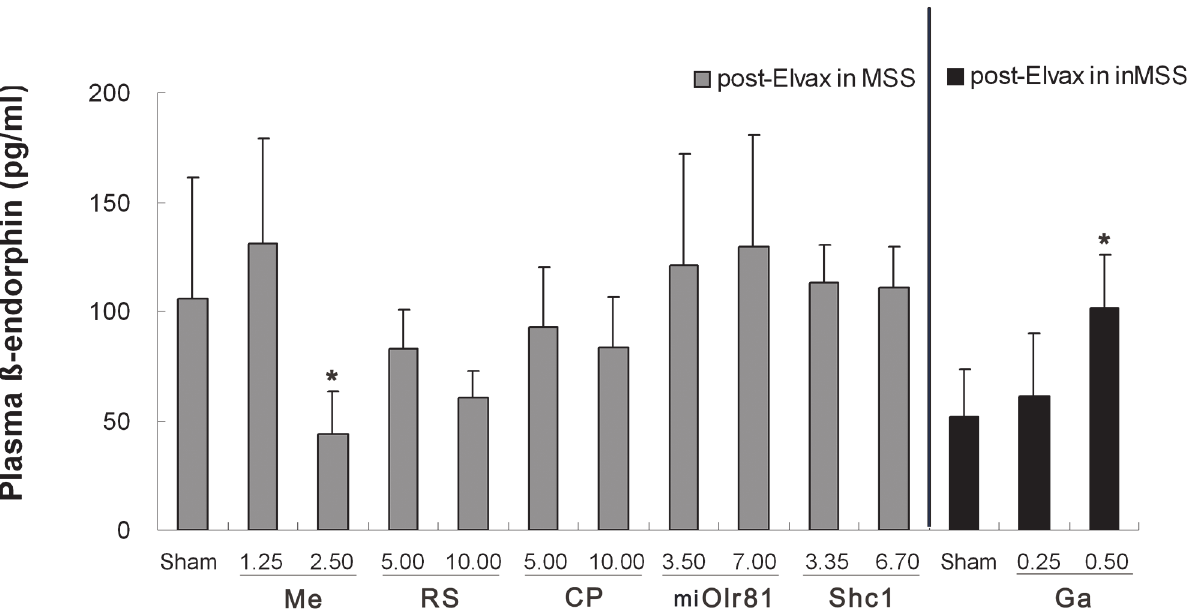
Fig 7. Effects of Elvax implantation over the CVN on plasma β -endorphin level after rotation stimulation. The final concentration of mecamylamine (Me), RS39604 (RS, CP99994 (CP) and gabazine (Ga) and the final titer of pAd-shOlr81 (shOlr81) and pAd-Shc1 (Shc1) in Elvax, and the number of animals used in each treatment group are the same as those in Fig 5. All data presented were expressed as the mean and vertical bars represent SEM. * P < 0.05 compared with sham control group.